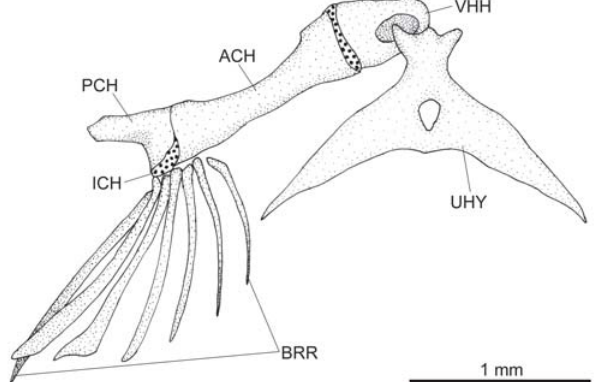
Fig. 5. Hyoid arch of Ituglanis macunaima , paratype, LIRP 5642 (29.1 mm SL), ventral view, left hyoid bar not shown. Abbreviations: ACH, anterior ceratohyal; BRR, branchiostegal rays; ICH, interceratohyal cartilage; PCH, posterior ceratohyal; UHY, urohyal; VHH, ventral hypohyal.